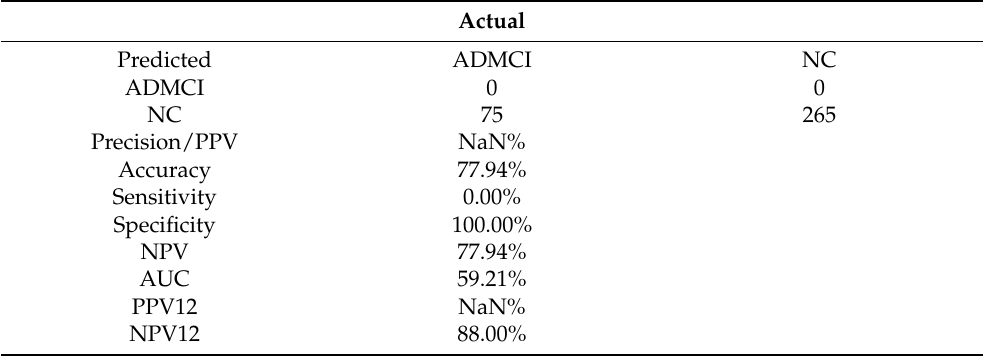
Table 3. Performance for testing set in 10 times repeated fivefold cross-validation without hyperpa- rameter tuning.